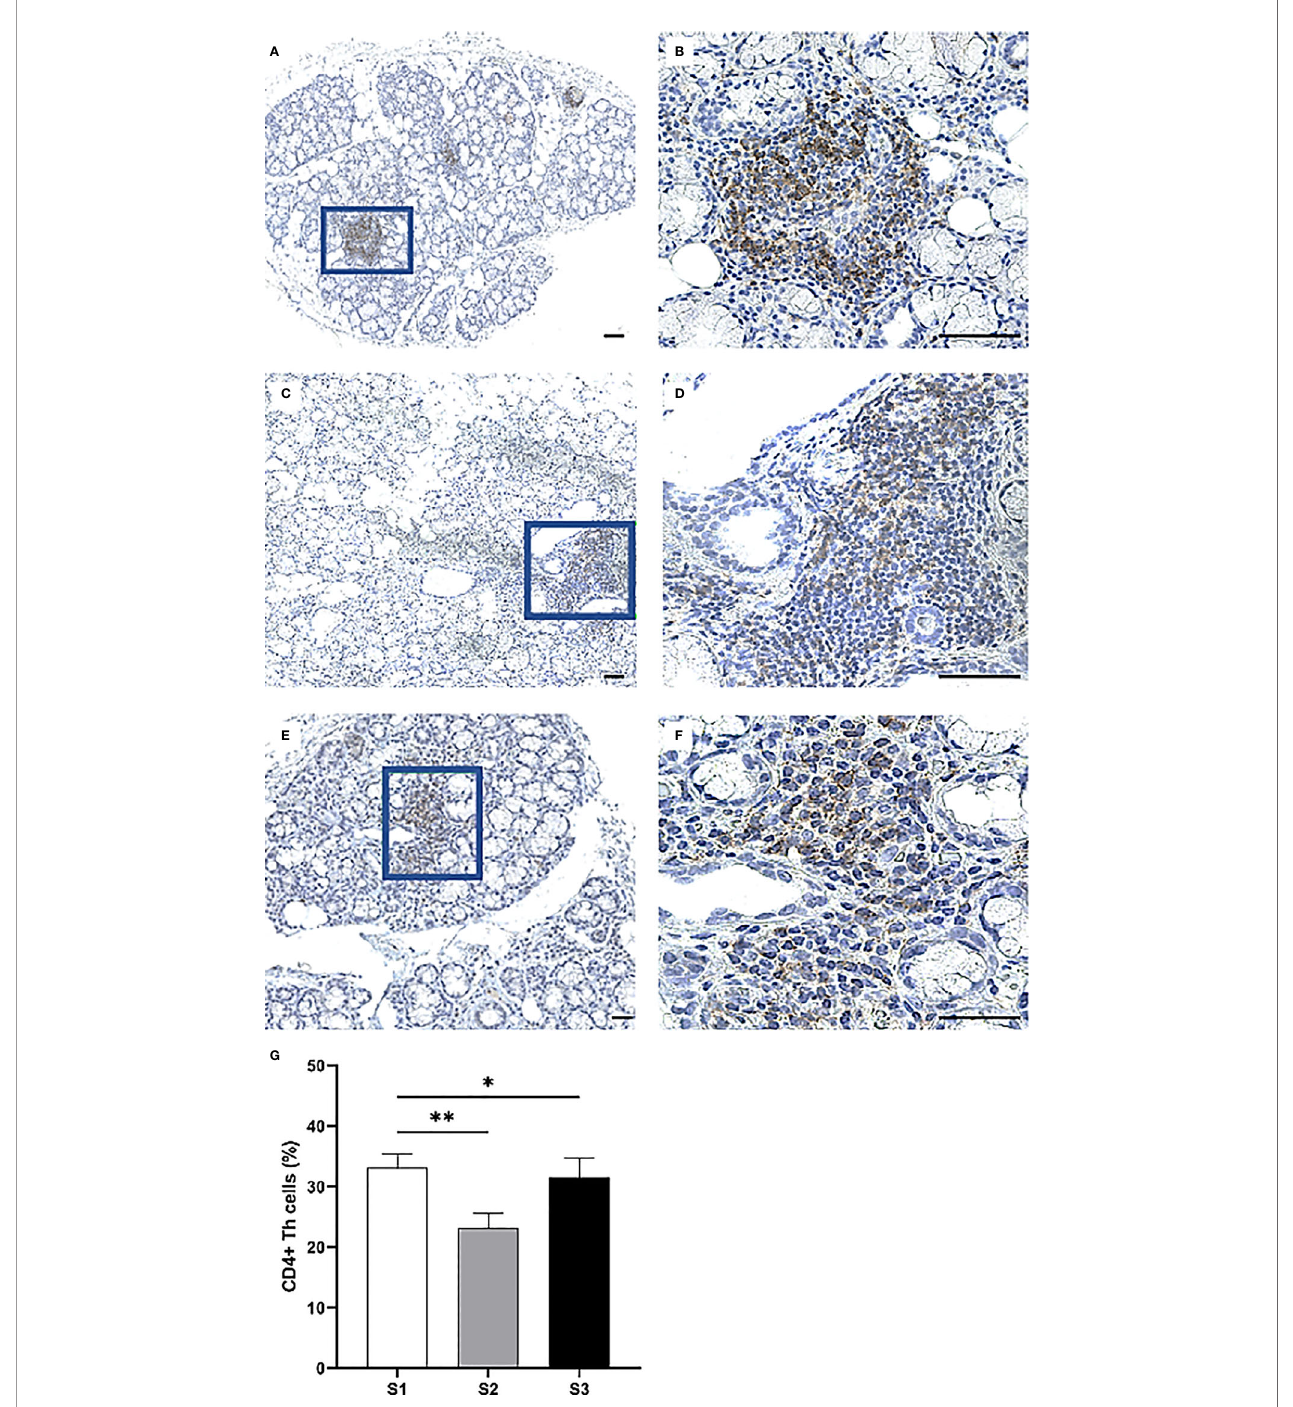
FIGURE 3 | Immunohistochemical detection and quanti fi cation of CD4 + Th cells in the MSG of pSS patients. CD4 + Th cells were most frequently observed in the focal in fi ltrates of MSG across all in fl ammatory severity stages (A – F) and dropped signi fi cantly in S2 compared to S1 ( p = 0.009), in addition to S2 compared to S1 and S3 combined ( p = 0.011) as determined by Student's T test (G) . Immunohistochemical staining displaying the distribution of a speci fi c immune cell in three representative examples of focal in fi ltrates in the MSG as classi fi ed into the respective in fl ammatory severity stages; S1 (A, B) , S2 (C, D) , and S3 (E, F) . Image (B) is a magni fi cation of (A) , image (D) is a magni fi cation of (C) , image (F) is a magni fi cation of (E) . Scale bar = 0.5 mm. Bars (G) indicate the mean percentage of cell-type number/total in fi ltrating mononuclear cells in each stage and error bars represent ± SEM. Statistical signi fi cance is notated: * = p < 0.05, ** = p ≤ 0.01. The Student's T test was